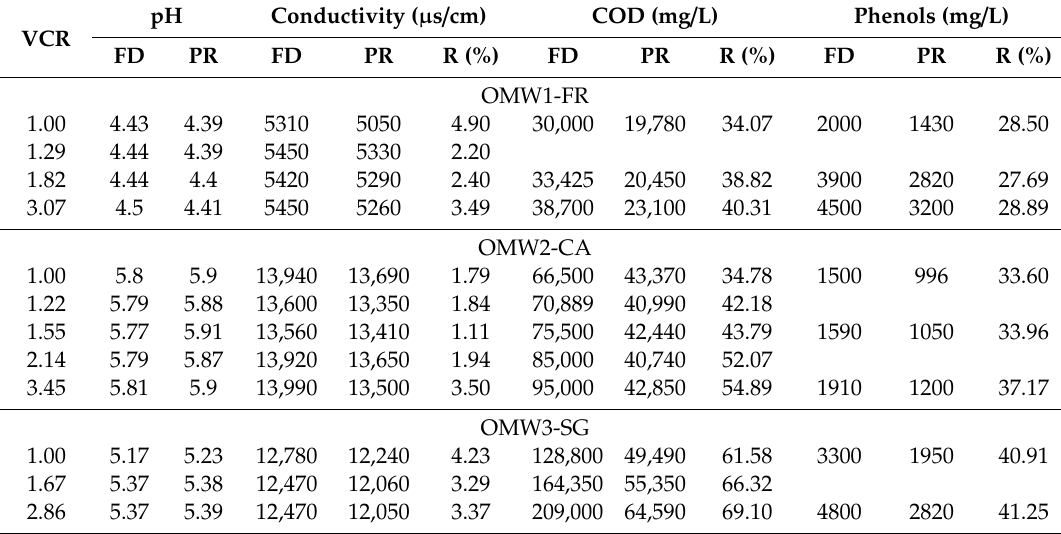
Table 5. Main physicochemical properties of feed (FD) and permeate (PR) samples collected during the MF tests with three di ff erent types of pH Conductivity (µs/cm) COD (mg/L)